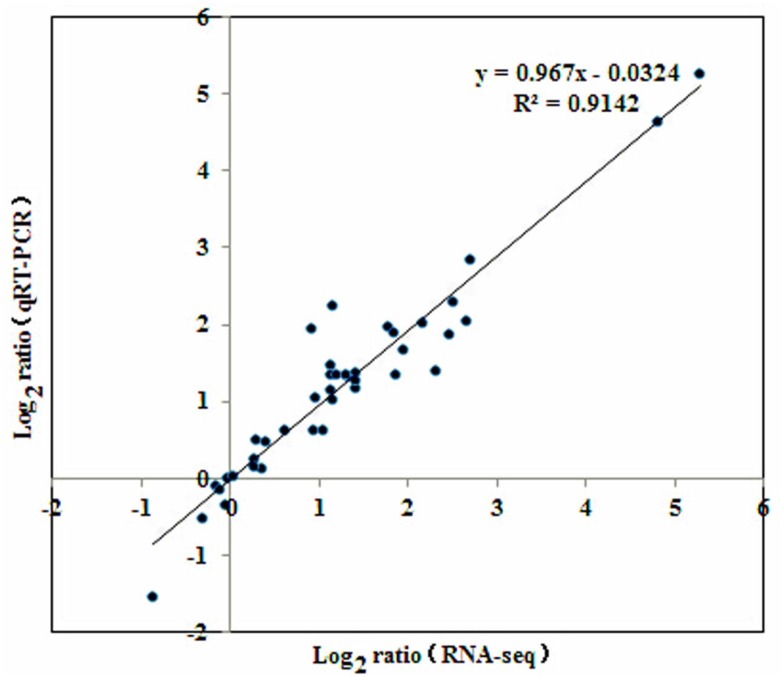
Consistency between RNA-Seq data and qRT-PCR data.Relationship between RNA-Seq data (x-axis) and qRT-PCR data (y-axis) using log2ratio measure of transcript levels of 20 genes.